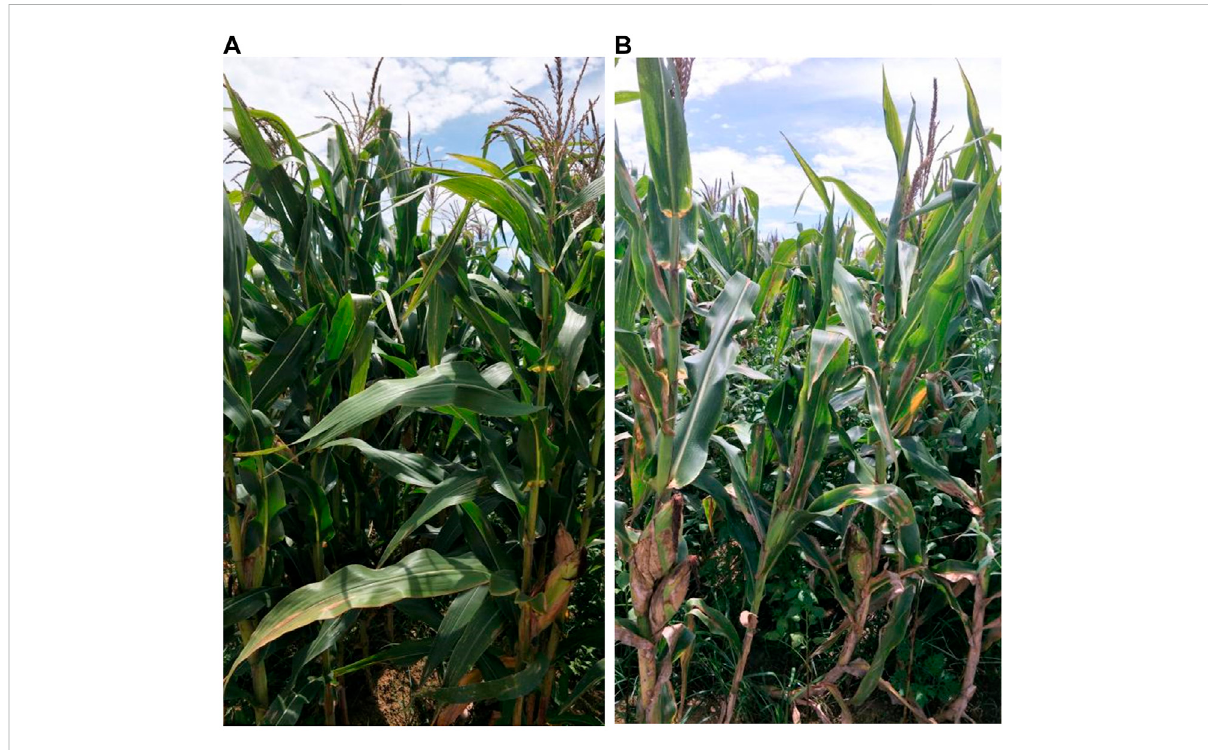
FIGURE 1 Morphological description of parental lines (A) GML71 (Resistant) and (B) Gui A10341